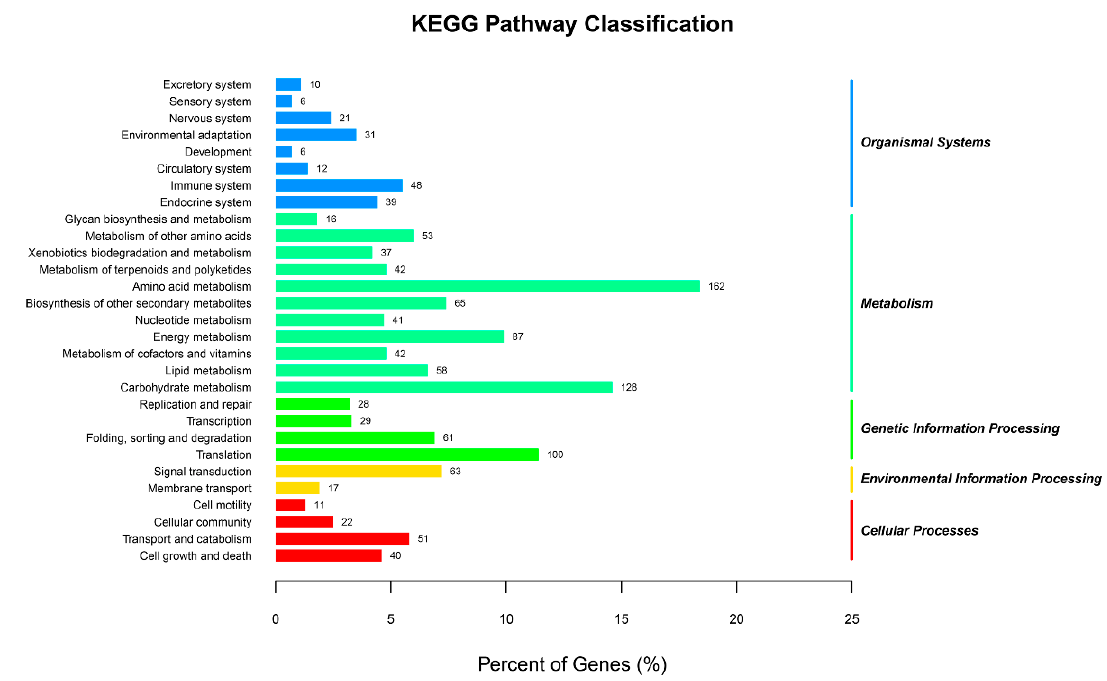
Figure 4. KEGG pathway classification of genes targeted by miRNAs.